Question: What style of plot is this figure drawn as?
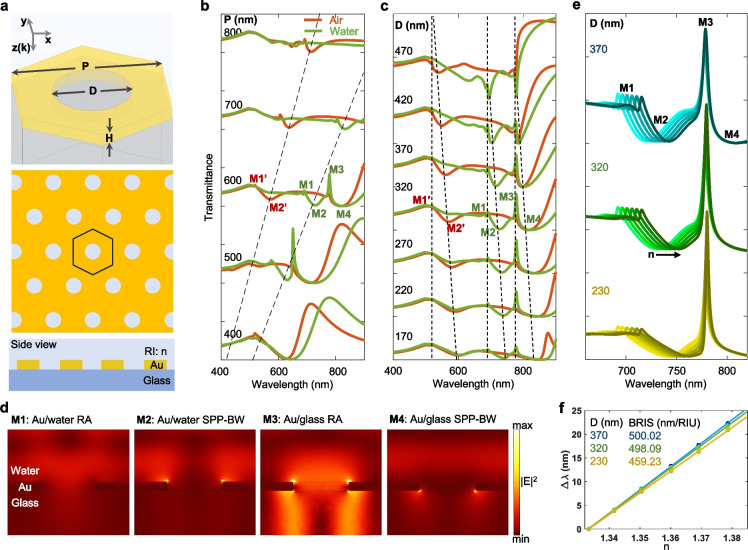
Answer: line